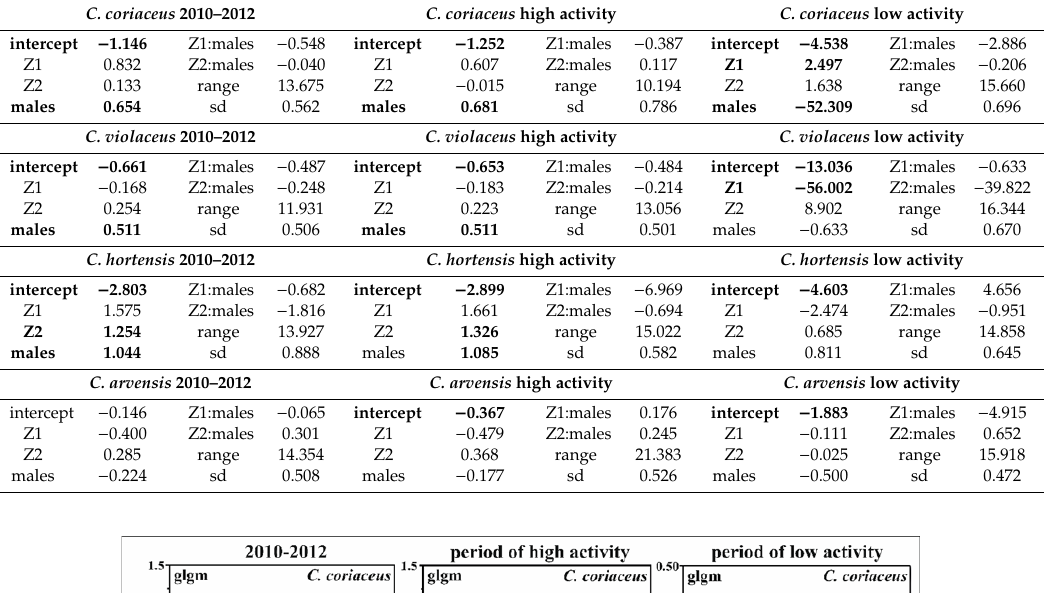
Table 3. Parameters of intraspecific comparisons explained by the generalised linear geostatistical model (glgm) related to the three zones of influence and di ff erentiated by periods of activity. (The significance of results at p -value 0.05 are highlighted by bold font).